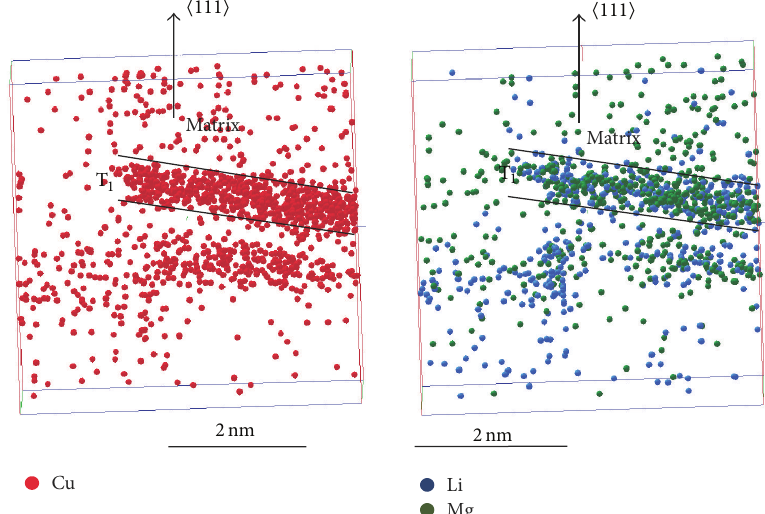
Figure 7: The magnified view of the T 1 platelet showing the density of Cu, Li, and Mg atoms at the matrix/precipitates interface.